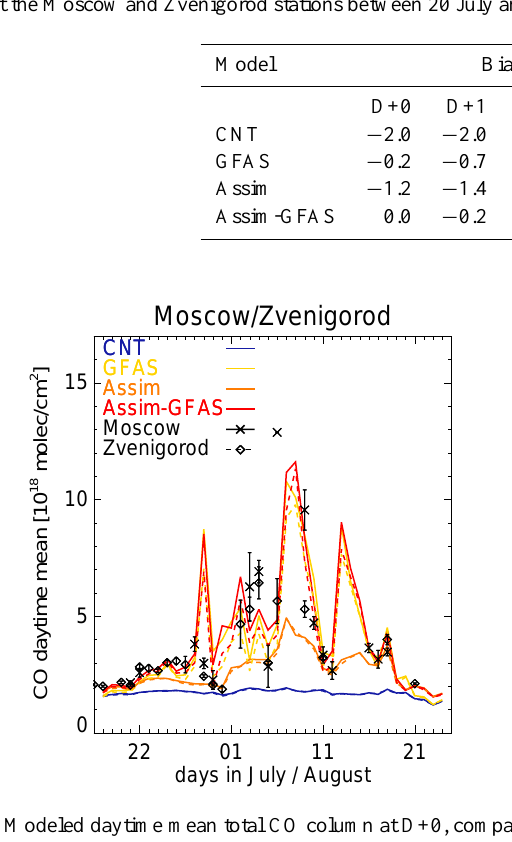
Fig. 7. Modeled daytime mean total CO column at D+0, compared to daily average ground-based column observations at the Moscow and Zvenigorod stations. The error bars reflect the daily variance in the available observations. Solid lines are model results interpolated to the Moscow station (55.7 ◦ N. 37.6 ◦ E). dashed lines correspond to Zvenigorod (55.7 ◦ N, 36.8 ◦